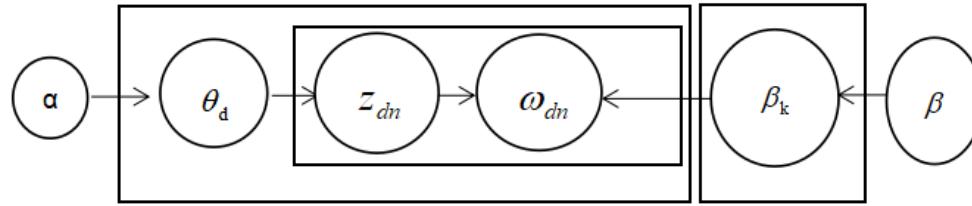
Figure 4. Best number of